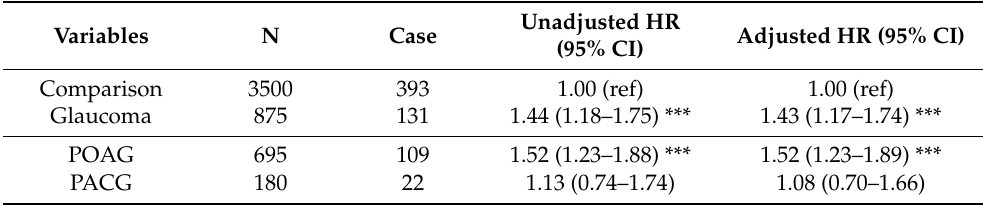
Table 3. The risk of incident dementia events between mid- to late-life glaucoma and comparison (non-glaucoma) groups.